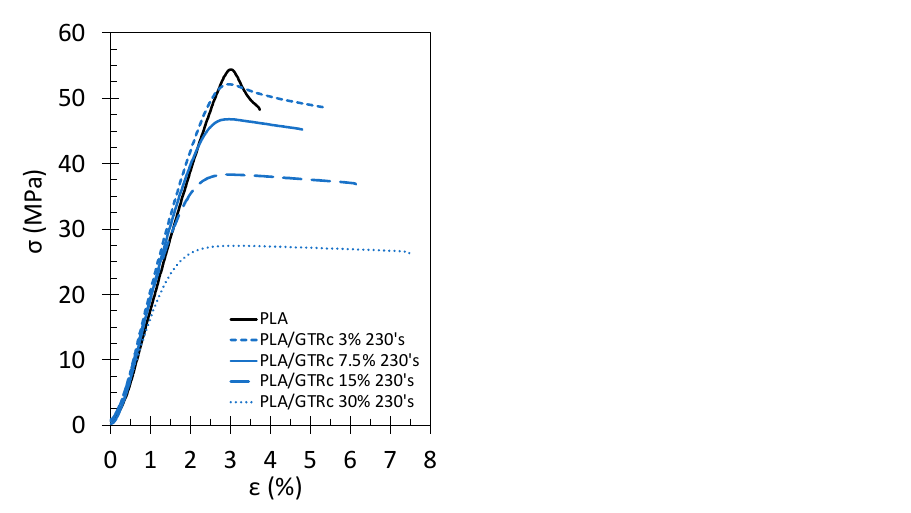
Figure 9. Engineering stress–strain curves of tensile test performed at 10 mm · min − 1 and at room temperature on the neat PLA without DCP (black continuous line), PLA/GTR a 7.5, 15 and 30 wt% sieved 230’s mesh with 1.5 wt% DCP (blue lines). All blends were processed at 170 °C in presence of Irganox (0.2 wt% of total amount of material).